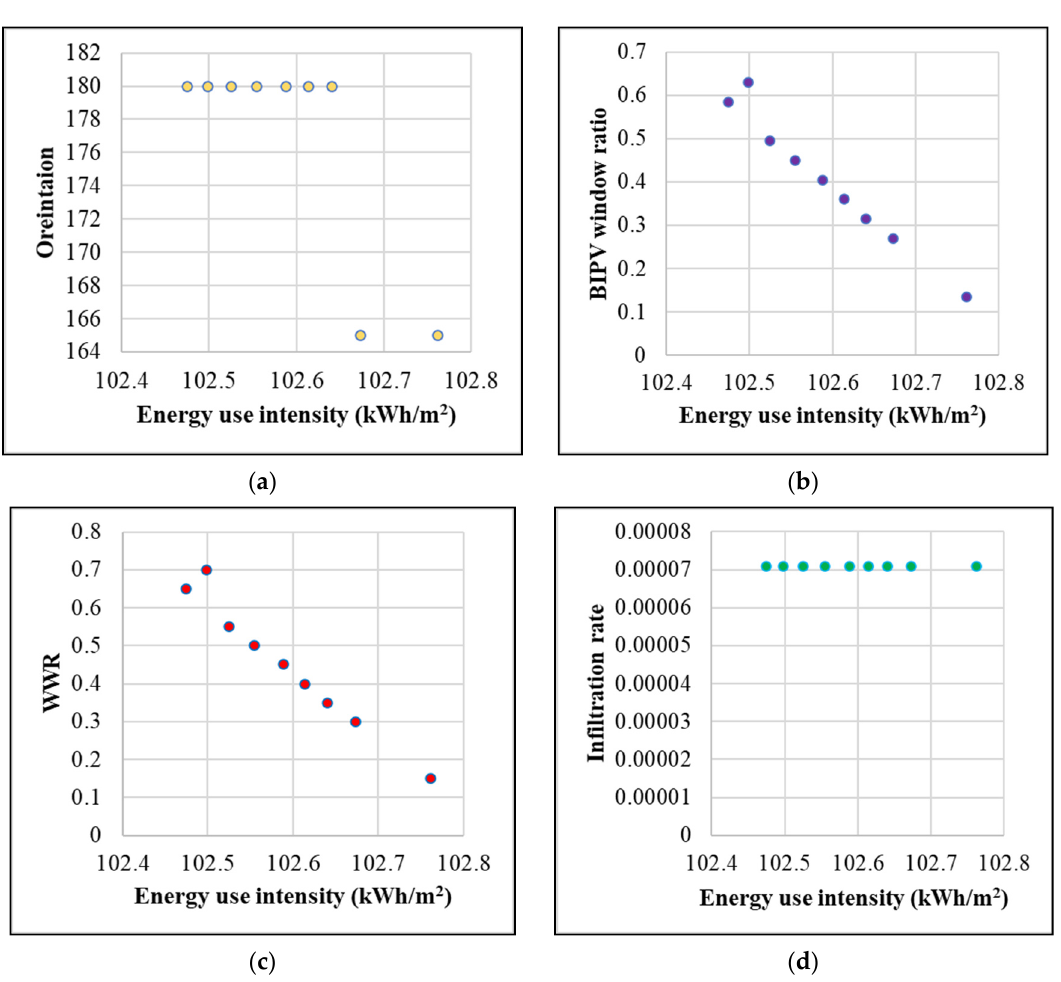
Figure 9. Scatterplot of WWR, infiltration rate, orientation, and BIPV window ratio against energy use intensity. ( a ) Orientation vs. energy use intensity, ( b ) BIPV windows ratio vs. energy use intensity, ( c ) WWR vs. energy use intensity, ( d ) Infiltration rate vs. energy use intensity.